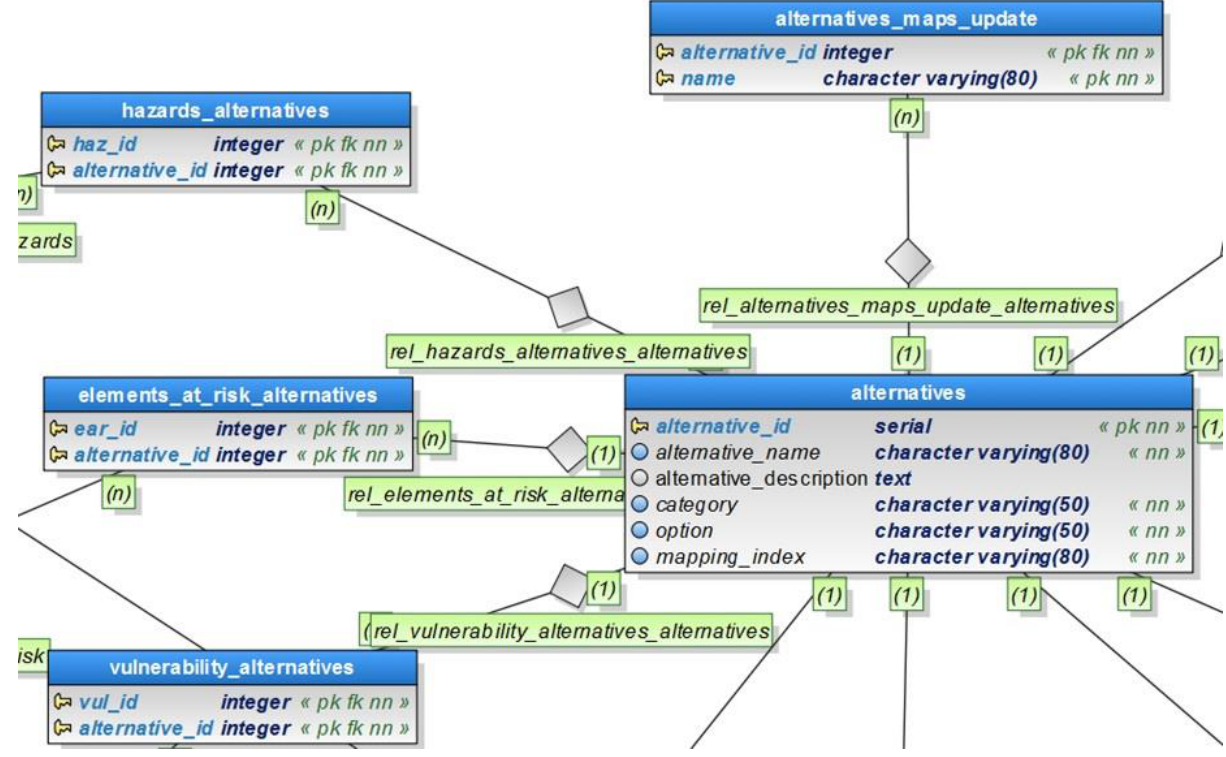
Figure 5. Data Model of the Alternative Management